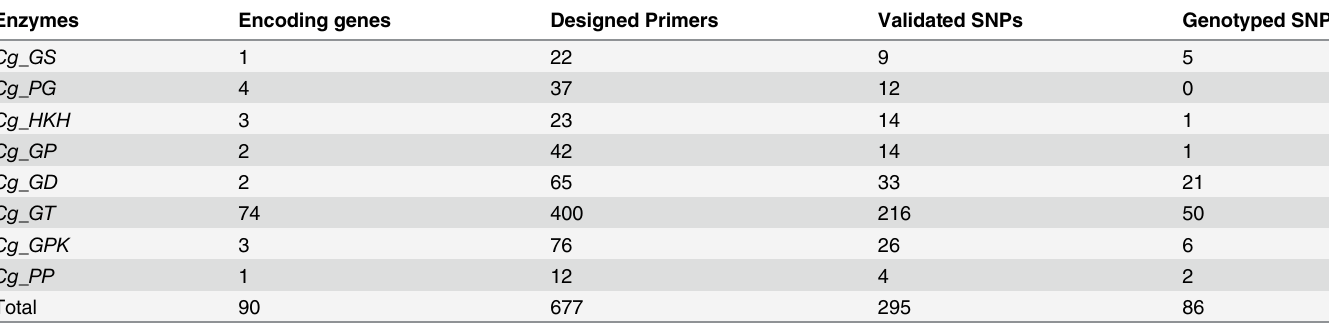
Table 1. Statistics for the polymorphisms of the glycogen content candidate genes.